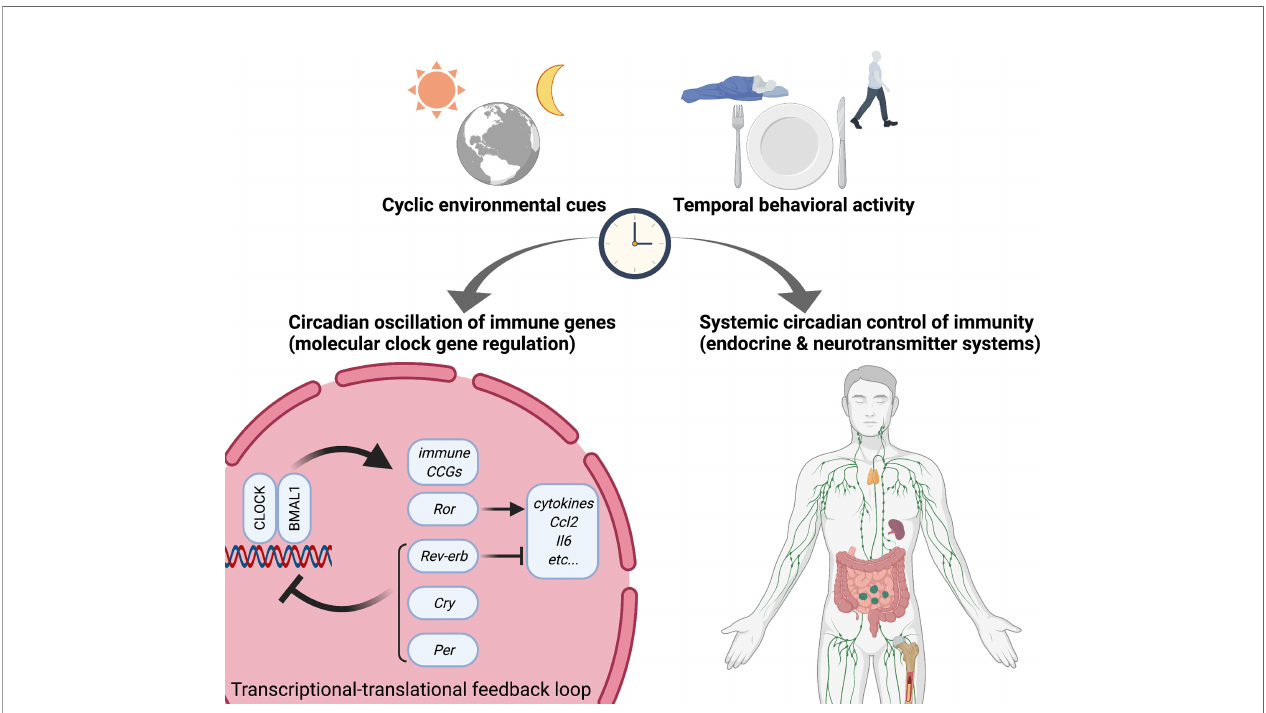
FIGURE 1 | Circadian rhythms in immunity. Circadian rhythms appear in multiple physiological responses including immunity, resulting in circadian gating of temporal diverse activity of immune functions. Not only do circadian endocrine and neurotransmitter mechanisms determine diurnal versus nocturnal immune responses but also molecular circadian clock directly trans-regulates cyclic gene expression related to immune functions such as cytokines and pattern recognition receptors (PRRs). Speci fi cally, several circadian transcription factors (activators) and repressors directly interact with the promoter regions of immune genes. Accordingly, misaligned circadian rhythms due to shift work (social jet-lag) and jet-lag disrupt temporal regulation of immune homeostasis and dynamic temporal balance of pro- and anti-in fl ammation. CLOCK, Circadian locomotor output cycles kaput; BMAL1, Brain and muscle ARNT-like 1; Ror, retinoic acid-related orphan receptor; Cry, Cryptochrome; Per, Period; CCG, clock-controlled